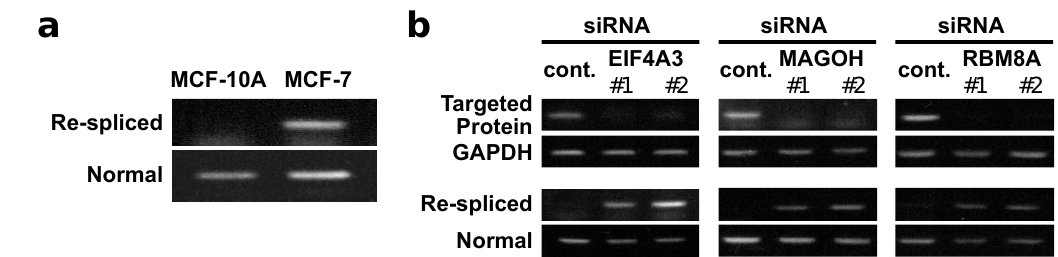
Figure 2. Depletion of EJC core factors can induce cancer-specific mRNA re-splicing in non-cancerous MCF-10A cells: ( a ) Total RNAs extracted from MCF-10A or MCF-7 cells were analyzed by RT – PCR using specific primer sets (see Figure 1a). ( b ) To knock-down the expression of endogenous EJC core factor genes, MCF-10A cells were transfected with the indicated siRNAs. To observe knocked-down efficiency and TSG101 re-splicing activity, the extracted total RNAs were analyzed by RT – PCR. The depletion of the targeted proteins was verified by immunoblotting (Figure S2).